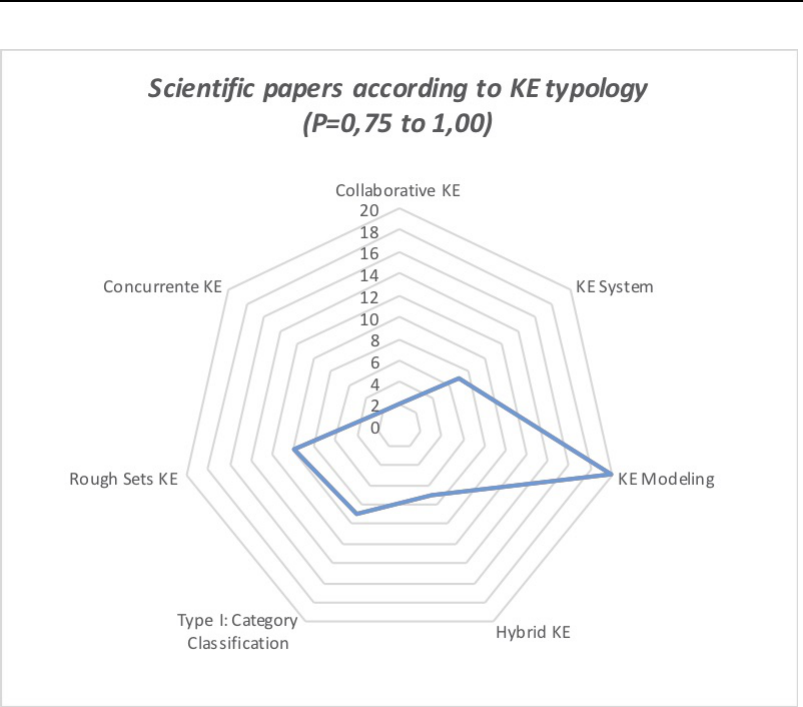
Figure 7. Incidence of KE typology on articles that obtained a score of P = 0.75 to P = 1.00. If this analysis is extended to all viewed papers, it shows which methodology the authors prefer (see Figure 8). Although with less incidence, it coincides with the predomi- nant typology in the papers classified with a high score, Type III with 24% and Type VIII with